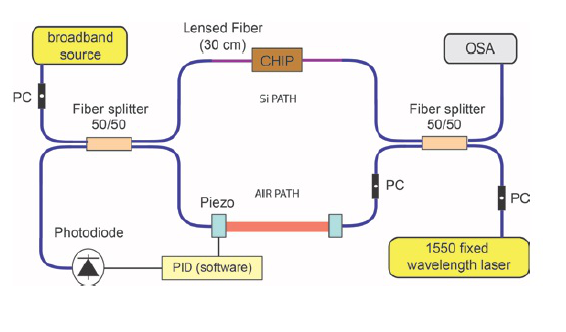
Fig. 3. A balanced interferometer to measure the group velocity dispersion of a waveguide. The interferometer is stabilized with the help of a 1550 nm laser. Adapted from reference [19].